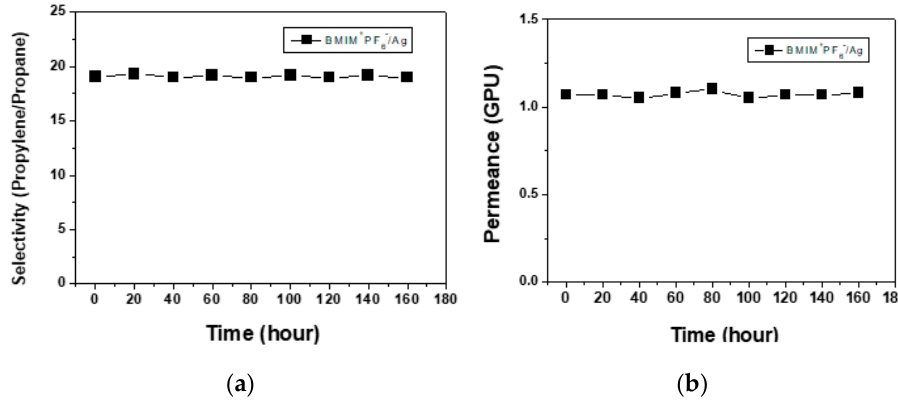
Figure 3. Separation performance: ( a ) mixed gas selectivity and ( b ) total permeance of 1/0.7 BMIM + PF 6 − /Ag membranes as a function of time (40 psig and 20 °C).